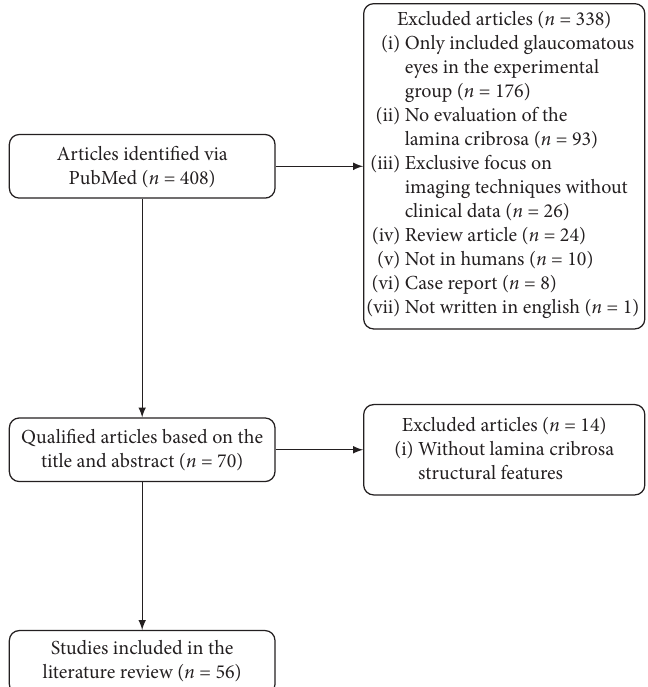
Figure 2: Flowchart of the collected data.